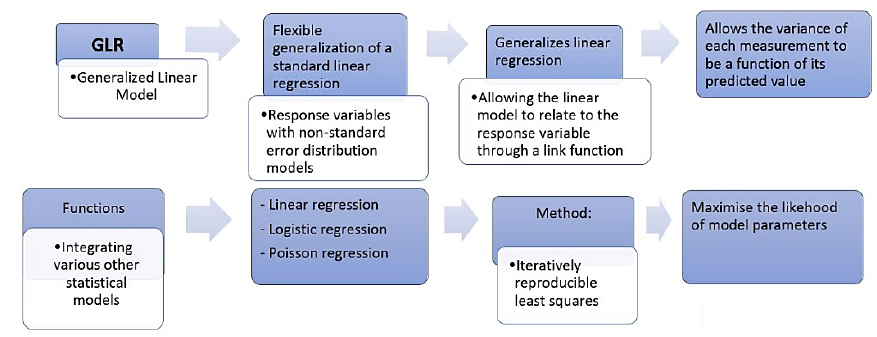
Fig. 4. Illustrated diagram of the GLAR